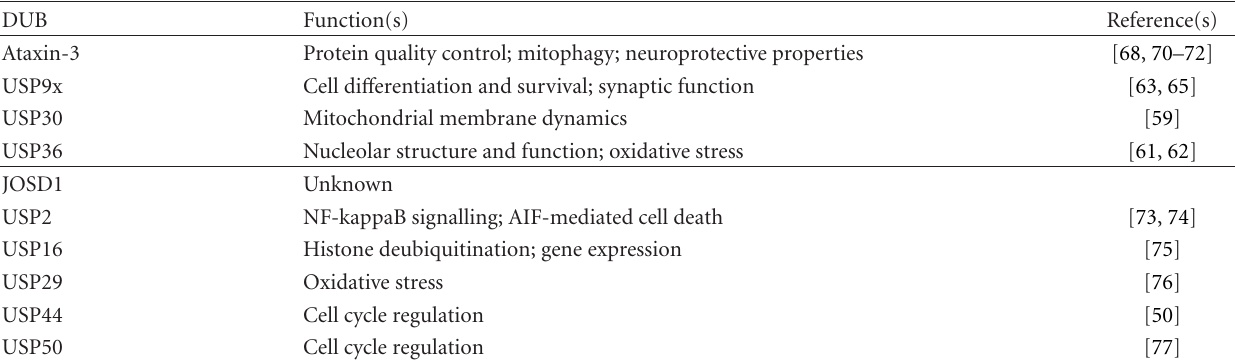
Table 1: Functions of known and predicted mitochondrial